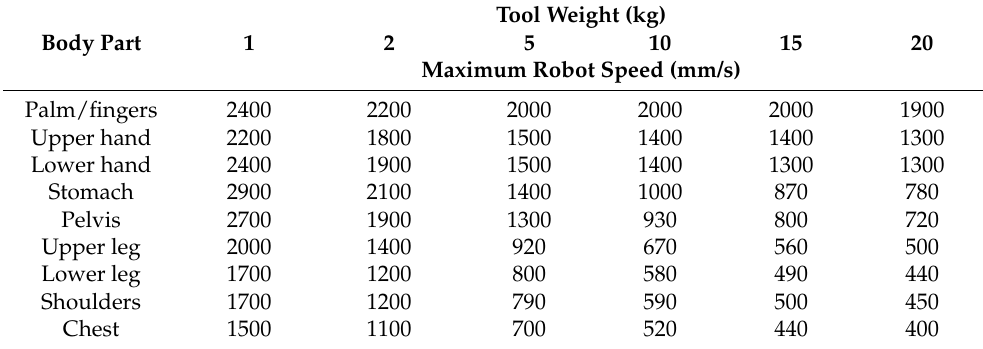
Table 1. Speed limits for transient contact according to ISO/TS 15,066, which specifies safety requirements for collaborative industrial robot systems and the work environment.